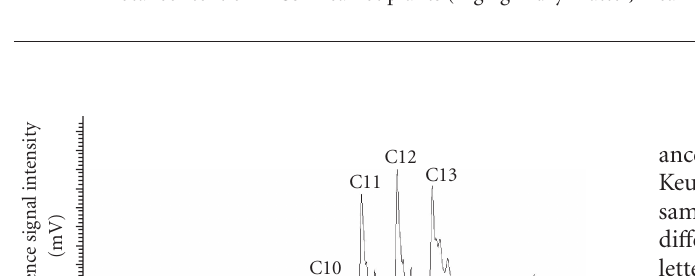
Total content of LASs in soil (initial) (mg kg − 1 dry matter, mean ± SE) Total content of LASs in carrot plants (mg kg − 1 dry matter, mean ± SE)